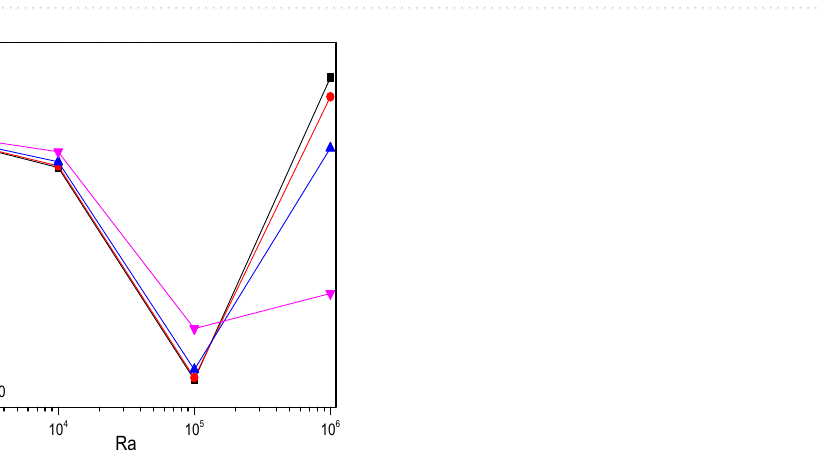
Figure 4. Variations of Nu avg with Ra for diverse Ha when Da = 0.01 , φ = 0.02 , ω = 0 , N = 4 , r = 0.1, and ε = 0.2